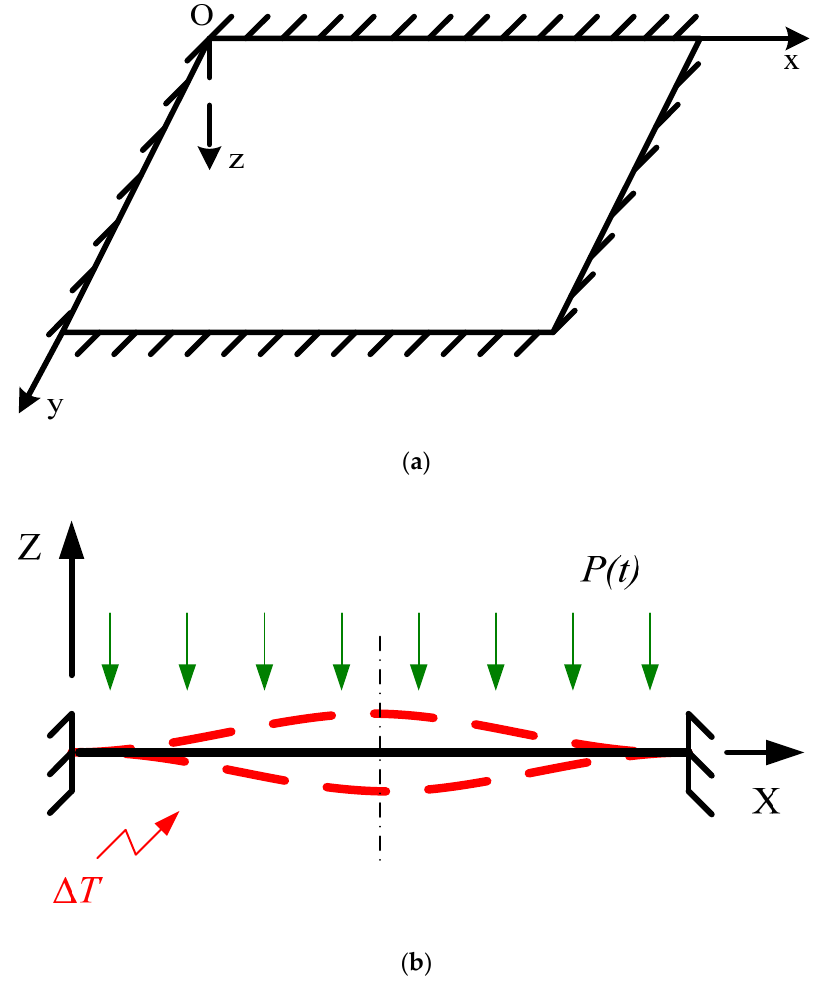
Figure 2. Panel subjected to thermal-acoustic loadings with full clamped boundary conditions. ( a ) Panel with full clamped boundary conditions; ( b ) Panel subjected to thermal-acoustic loadings. Table 1. Material property of 2D plain-woven C/SiC ceramic matrix